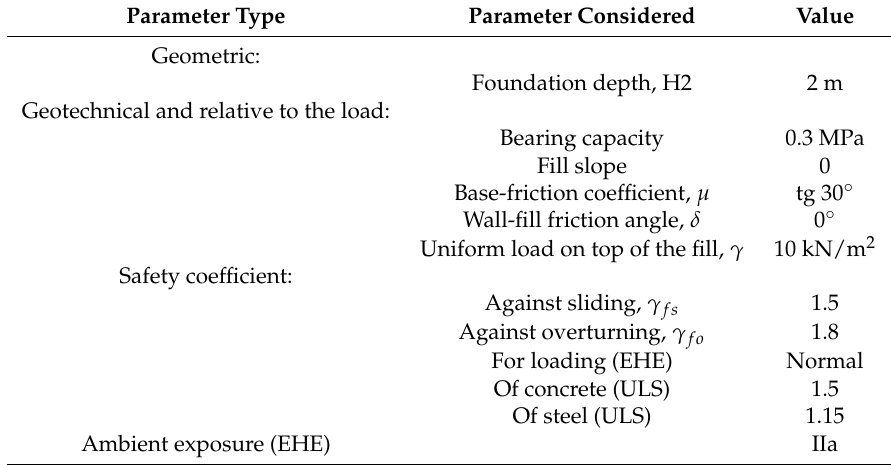
Table 3. Problem design parameters